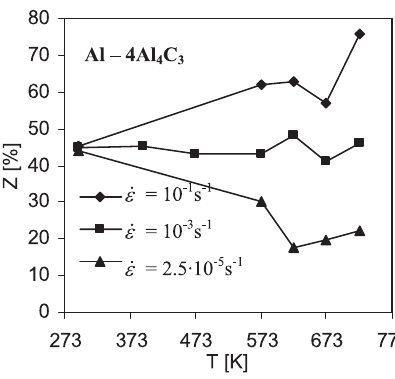
Fig. 10: Reduction of area Z as a function of strain rate and temperature